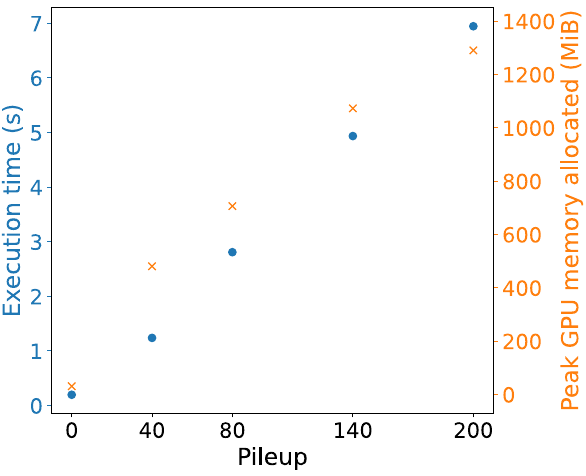
Fig. 8 Computespecificationsofourmodelasafunctionoftheamount of pileup to run inference with one event. The left axis (blue) shows average execution time, and the right (orange) shows the average peak memory allocated on the